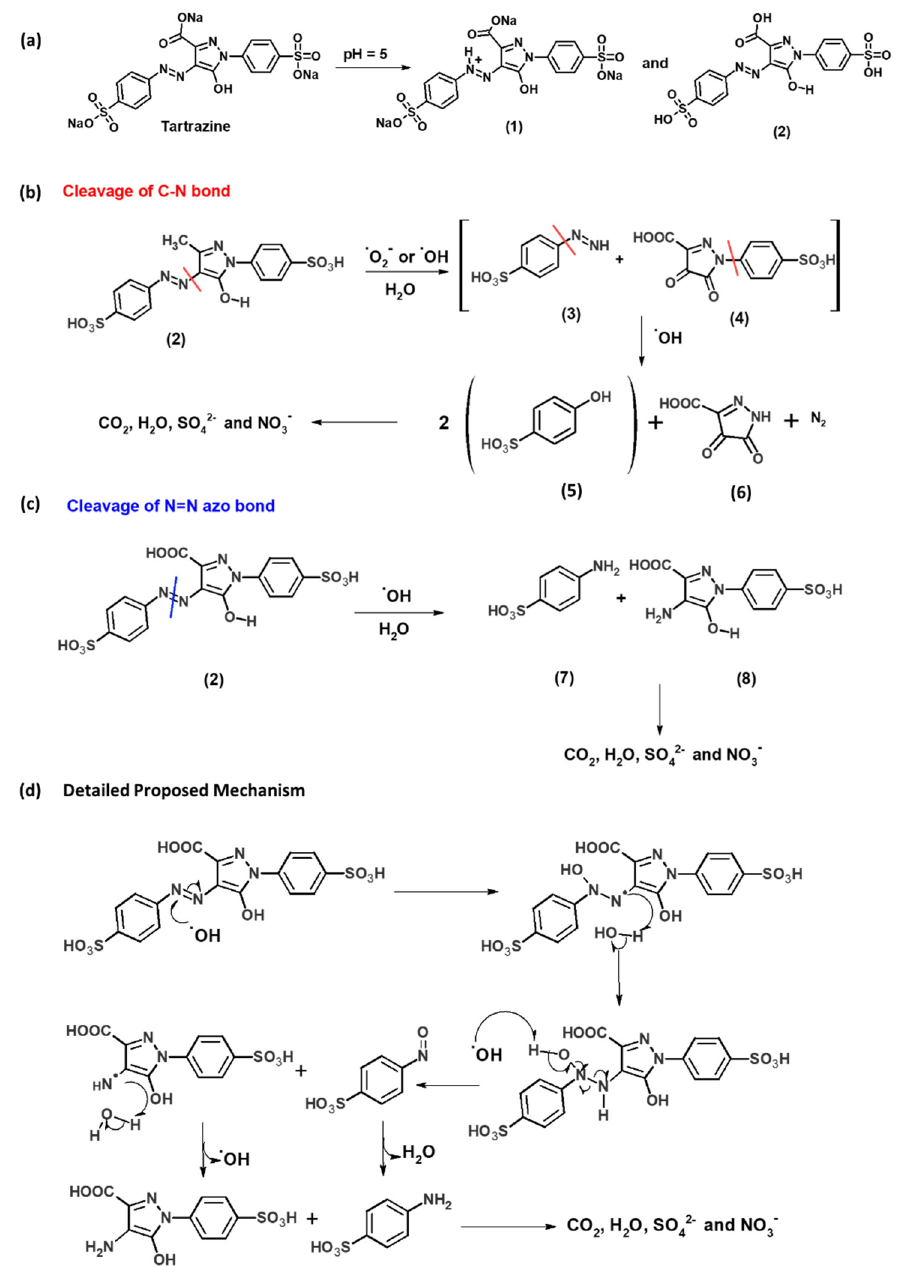
Figure 12. Mechanism proposed for the Y5 degradation. ( a ) Species of tartrazine in solution at pH = 5. ( b ) Cleavage of C–N bond. ( c ): Cleavage of N=N azo bond. ( d ) Detailed proposed mechanism based on the successive attack of •OH radical.